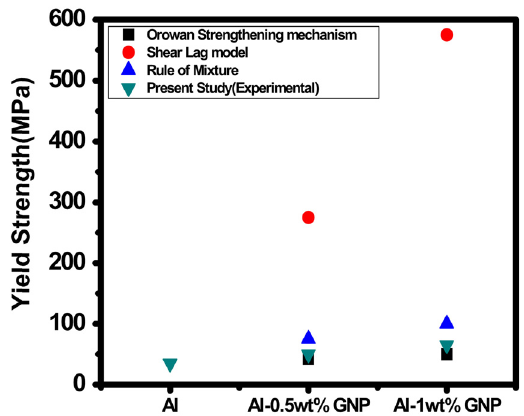
Figure 5: Comparison of yield strength ( MPa ) calculated from var - ious strengthening mechanism models and the experimental data. Reproduced from ref. [ 32 ]